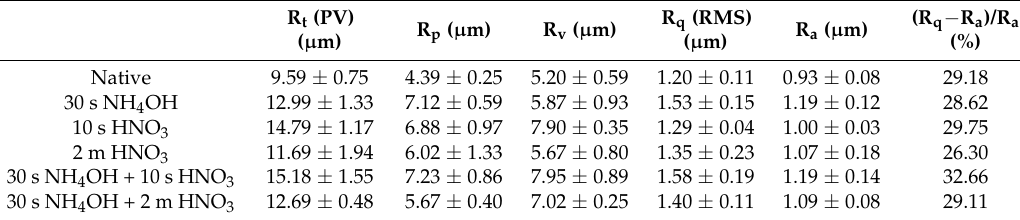
Table 2. Surface (area) roughness data for the native flattened Ag wire and the different flattened Ag wires after chemical etching treatments. ( n = 6, mean ± standard error of mean).